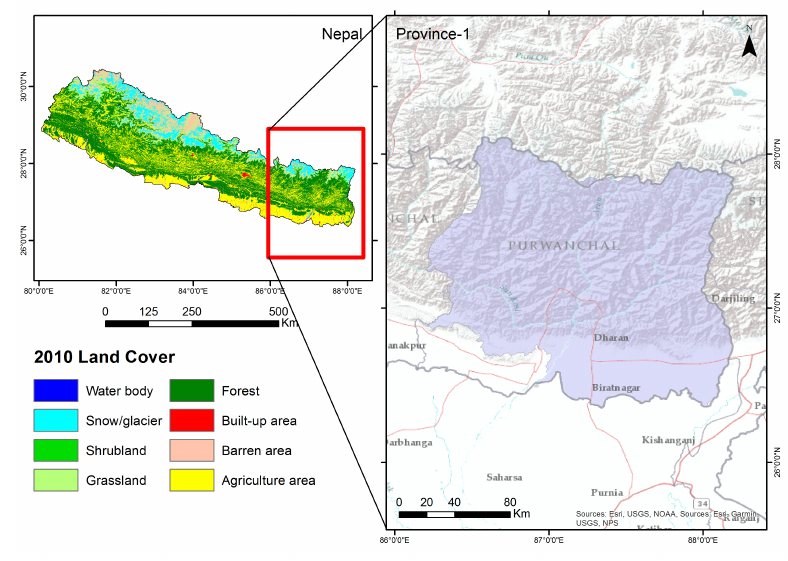
Figure 1. Province 1 ( right ) is located in the eastern part of Nepal ( left ). The different colours indicate the 2010 land cover